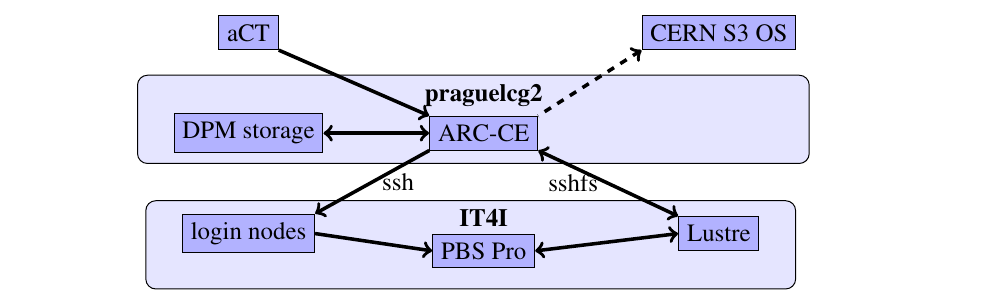
Figure 1. A scheme of the job submission